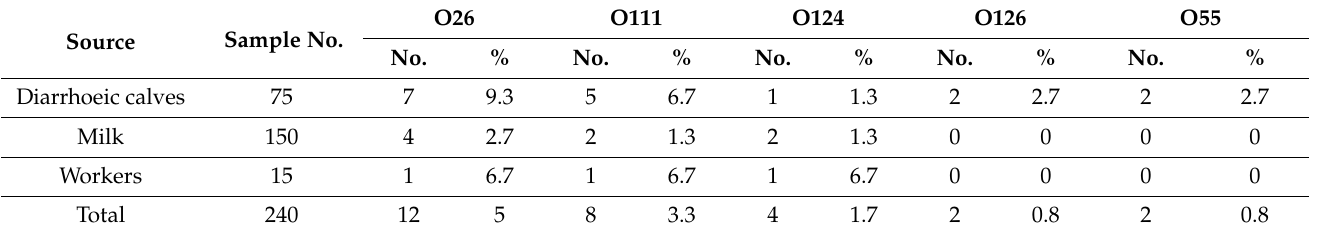
Table 2. Frequency distribution of EPEC serovars per